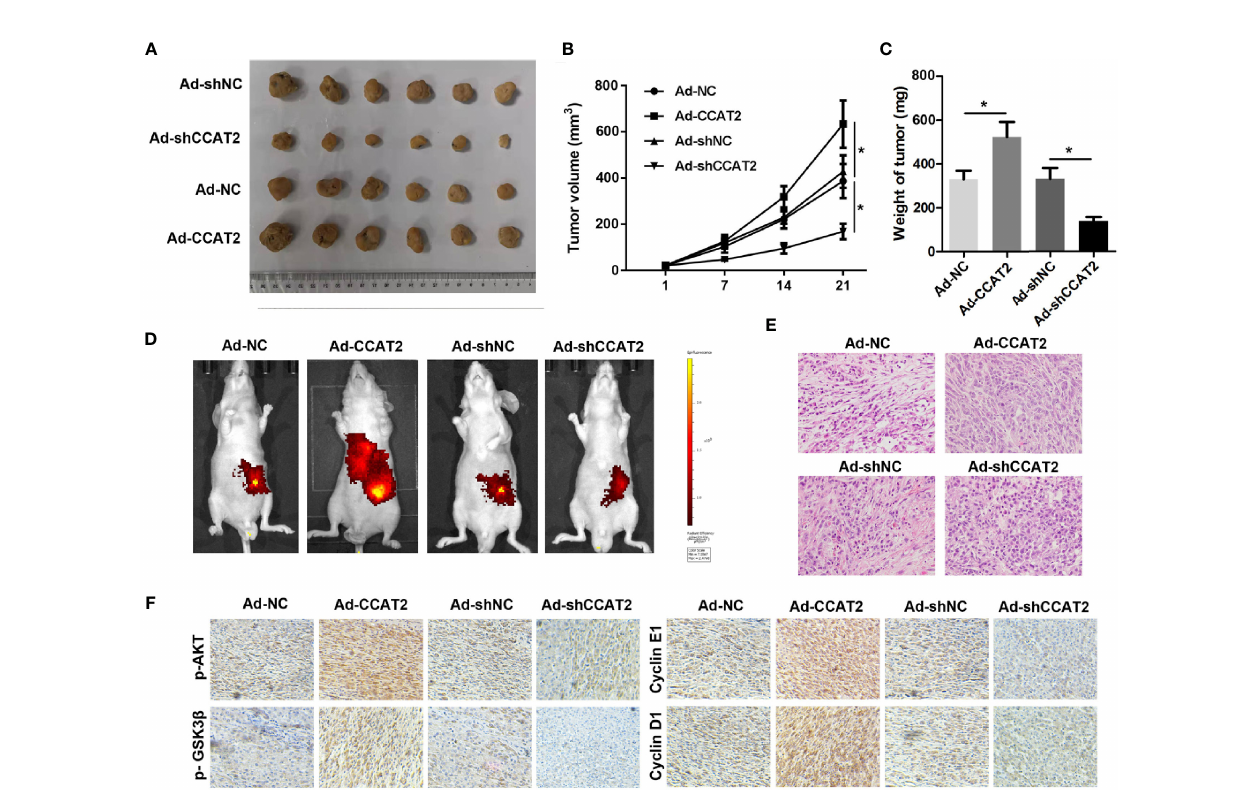
FIGURE 8 | CCAT2 promoted the subcutaneous xenograft growth of colorectal cancer cells and hepatic metastasis in nude mice. (A) SW620 cells infected with Ad-CCAT2, Ad-shCCAT2 or their controls were subcutaneously injected into the back of nude mice. The tumors that developed were resected and visualized. (B) The growth curve of the tumors in each group was analyzed. (C) Average tumor volume and weight indicated that CCAT2 inhibited tumor growth in vivo . (D) Bioluminescent imaging was used to detect SW620 metastasis. (E) HE staining was performed to evaluate the EMT potential of SW620 cells in each group (×200). The data are represented as mean ± SD. Three independent biological repeats were used for each analysis. *P < 0.05 (F) IHC was performed to evaluate the expression of p-AKT, p-GSK3â, cyclin D1 and cyclin